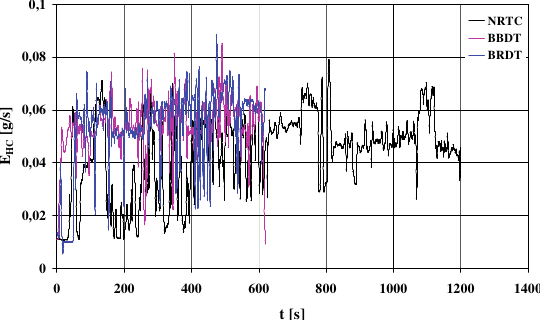
Fig. 9. The set of engine operational states engine speed – n, torque – M e in the BRDT test; (AV[n], AV[M e ]) – the coordinates of the average values of the engine speed and engine torque